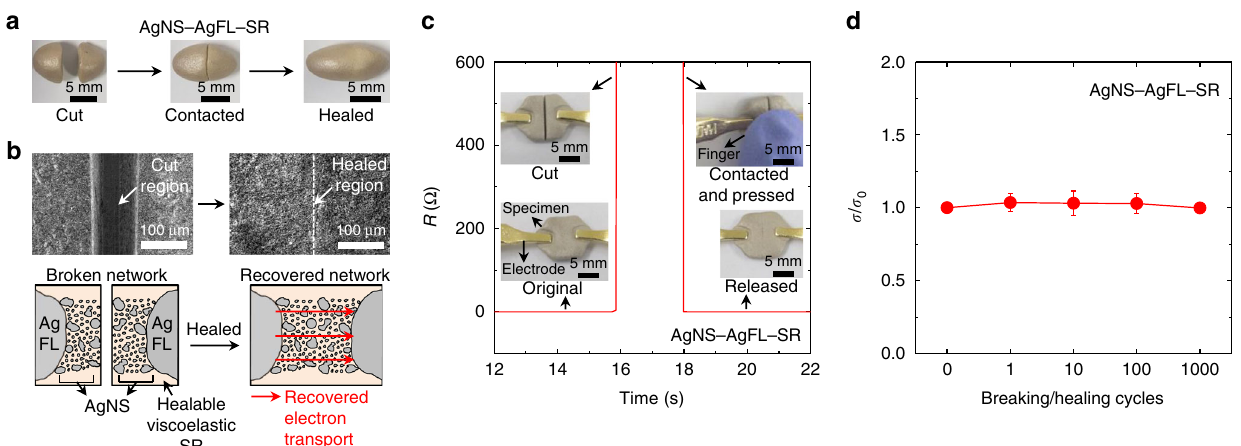
Fig. 4 Healable electrical transport of the AgNS-AgFL-SR nanocomposite. a, b Optical and SEM images of the AgNS-AgFL-SR (Ag = 44 vol%, THF peroxide = 15 mL) nanocomposite after breaking and healing. Schematics of the healable AgNS network are also provided. c The resistance change of the AgNS-AgFL-SR nanocomposite during a breaking/healing cycle. An optical image at each step is also provided. d The normalized electrical conductivity of the AgNS-AgFL-SR nanocomposite is shown as a function of the breaking/healing cycles. The error bars represent the standard deviation of the Fig. 3c, the ρ of AgNS-AgFL-SR nanocomposite was close to the (Fig. 4b schematic), without the need for diffusion, re-orientation, theoretical value calculated by the rule of mixture 41 . The densely and recontact of fi llers. The σ of the AgNS-AgFL-SR nano- and uniformly distributed fi llers were embedded in the polymer composite was completely recovered (electrical healing ef fi ciency, = ~100%) even after 1000 breaking/healing cycles (Fig. 4d). σ / σ matrix without air voids. The other control specimens showed a 0 lower ρ probably due to the air voids which scattered electrons and decreased σ .